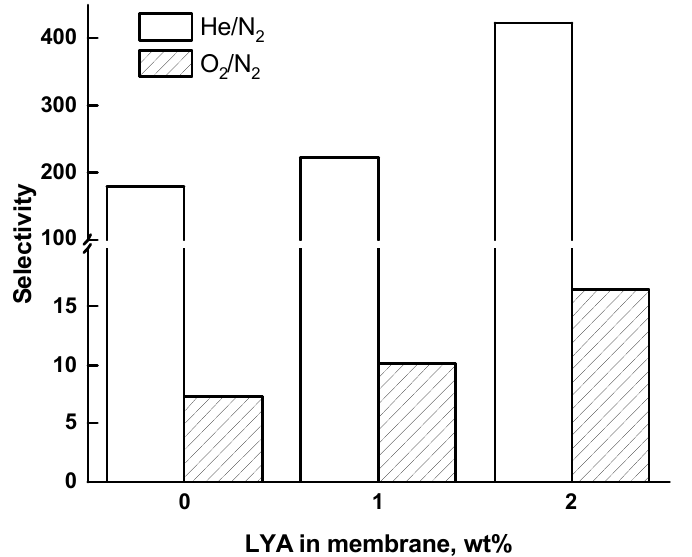
Figure 14. Dependence of ideal selectivity on the LYA content in the membrane for He/N 2 and O 2 /N 2 at 20 ◦ C.